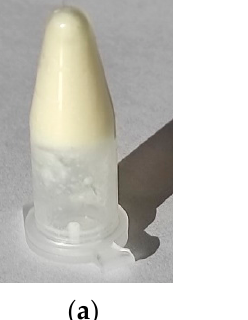
Figure 6. C 12 Ala-AgNPs ( a ) before, ( b ) after rotation, and ( c ) after 24 h of storing.